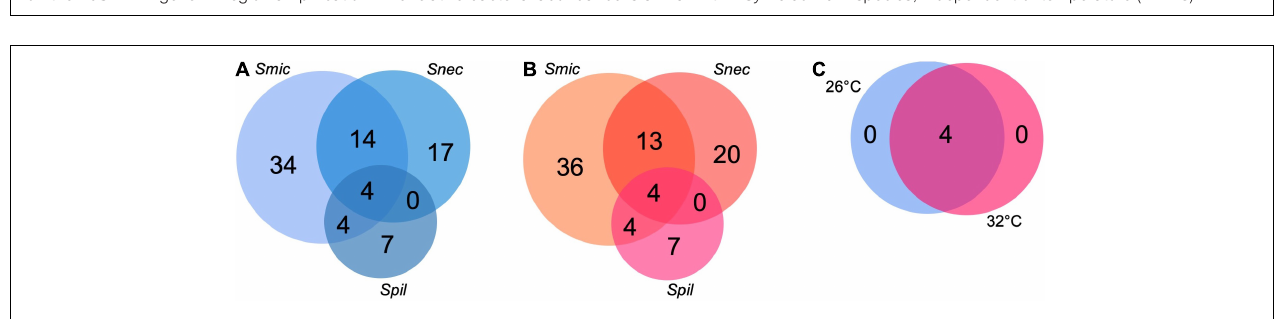
FIGURE 3 | Bacterial community composition (relative abundance in percentage) of Symbiodinium species in culture under 26 and 32 ◦ C at the genus level, based on the 16S rRNA gene v4 region amplification. The relative bacterial abundance is similar within Symbiodinium species, independent of temperature ( n = 18).